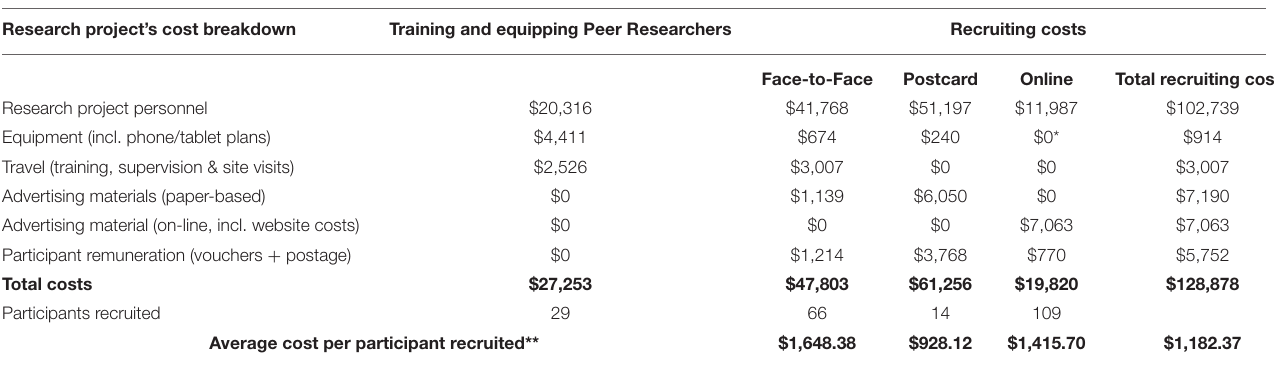
TABLE 2 | Summary of study recruitment costs